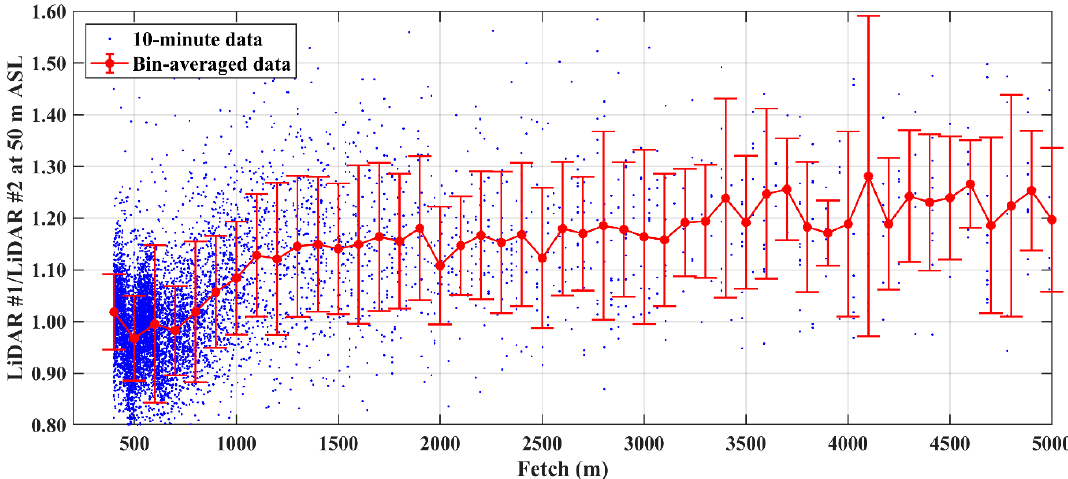
Figure 12. Wind speed ratio as a function of fetch length at 50 m ASL.